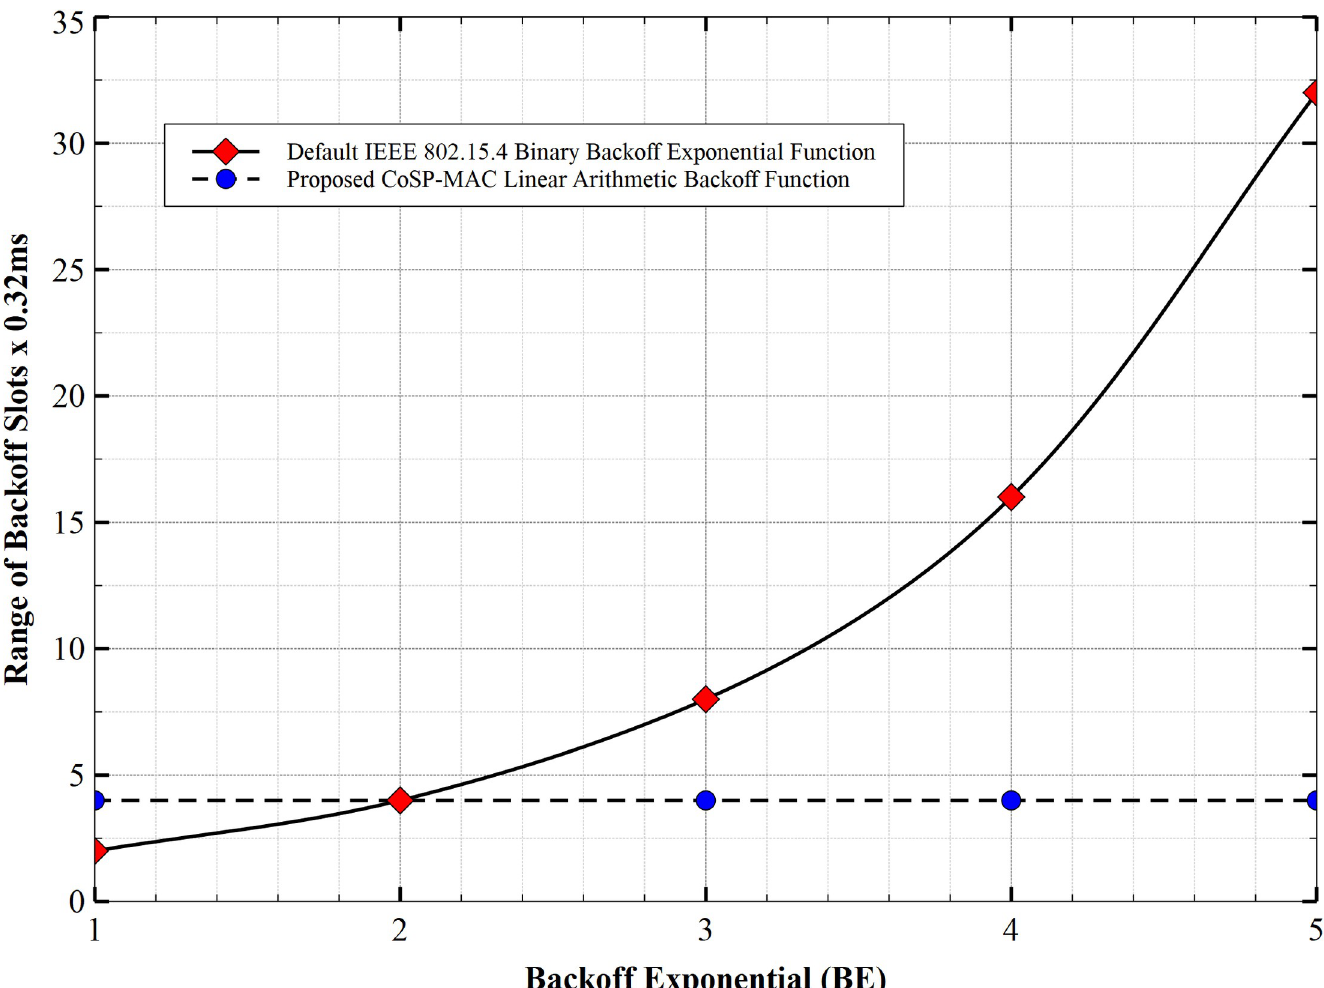
Fig 6. CSTP-MAC algorithm backoff time-slots vs IEEE 802.15.4 binary backoff exponential algorithm backoff time-slots.